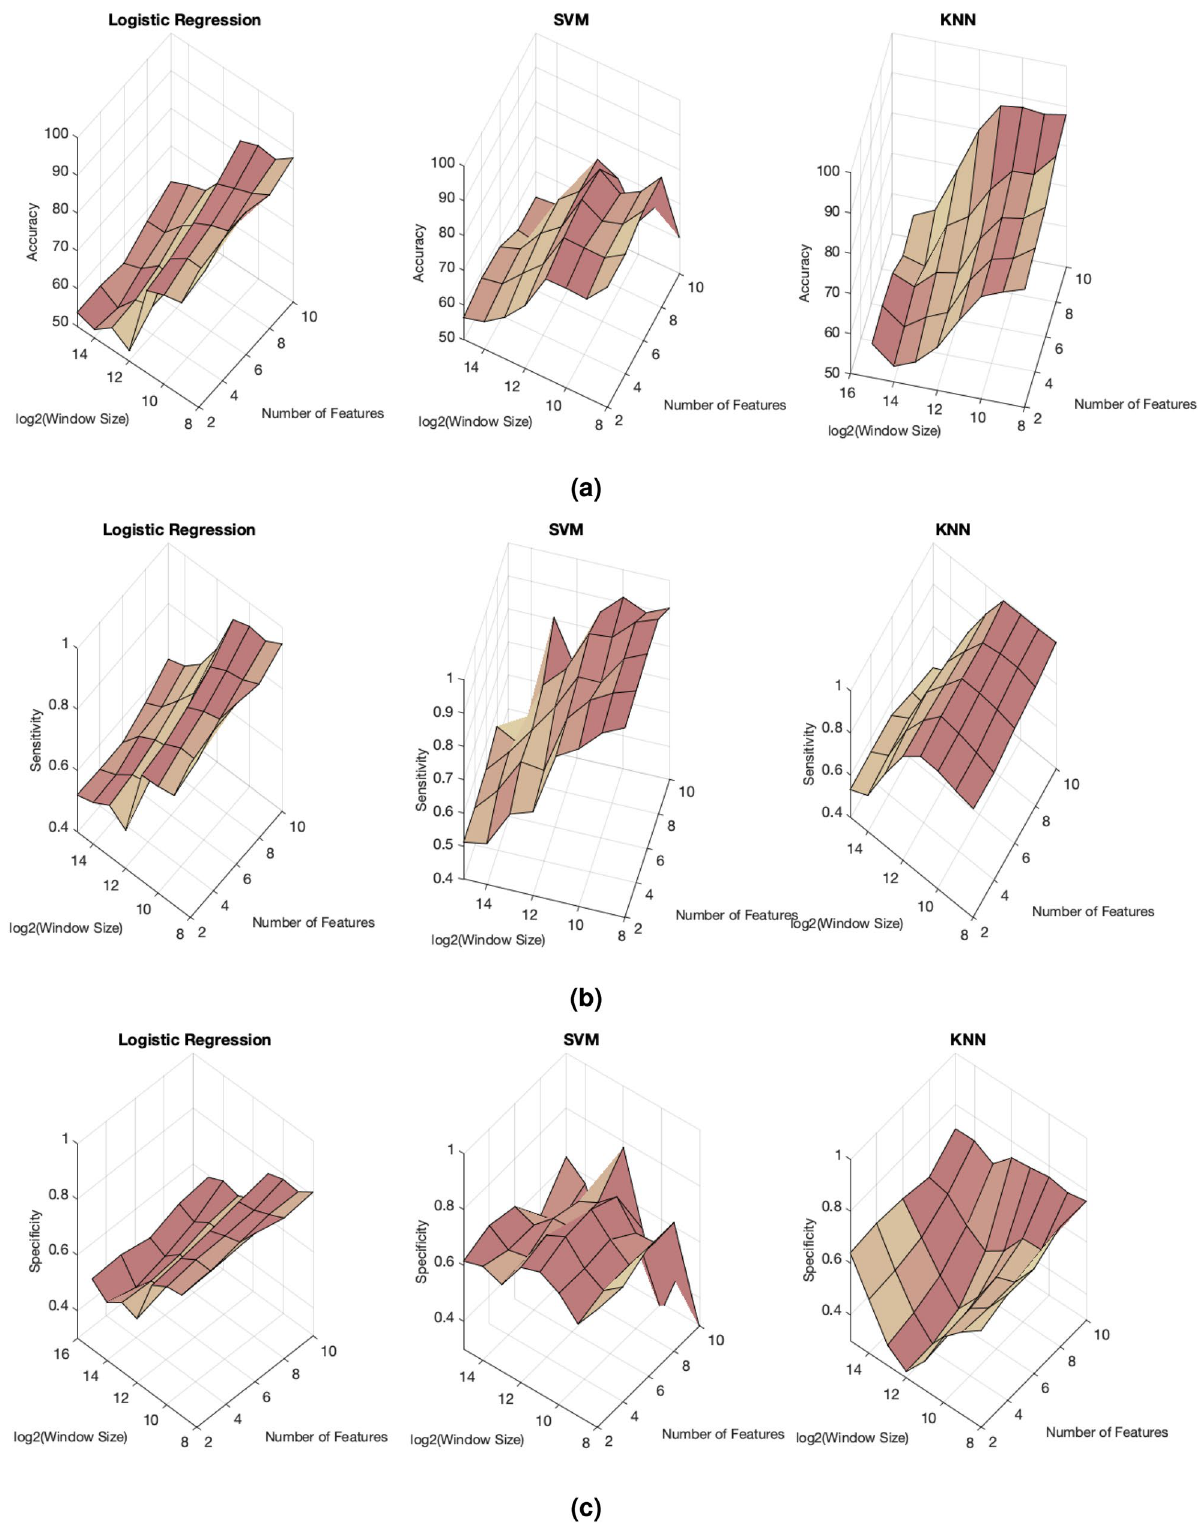
Figure 6. Change in classification performance ( a ) accuracy, ( b ) sensitivity and ( c ) specificity with the window size and the number of